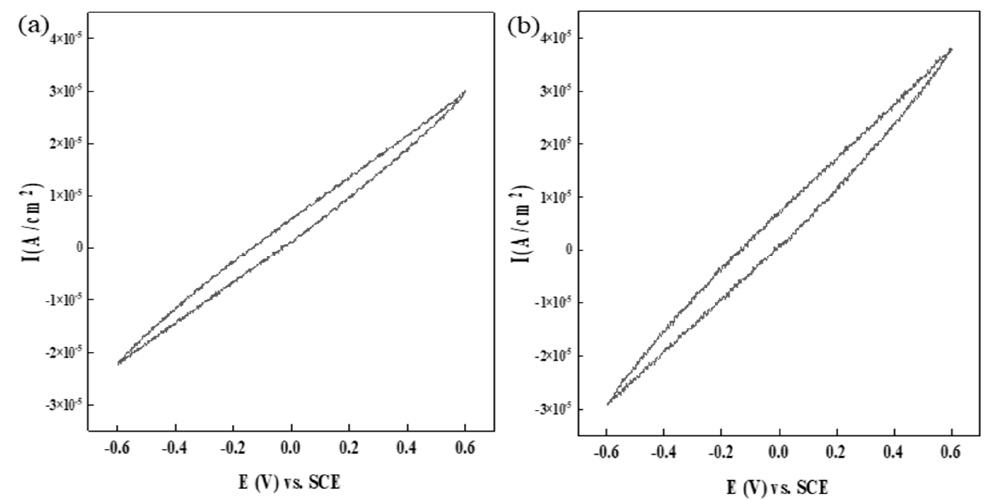
Figure 9. Cyclic voltammetry curves of prepared samples with different scanning rates: ( a ) 50 mV/s, ( b ) 100 mV/s.